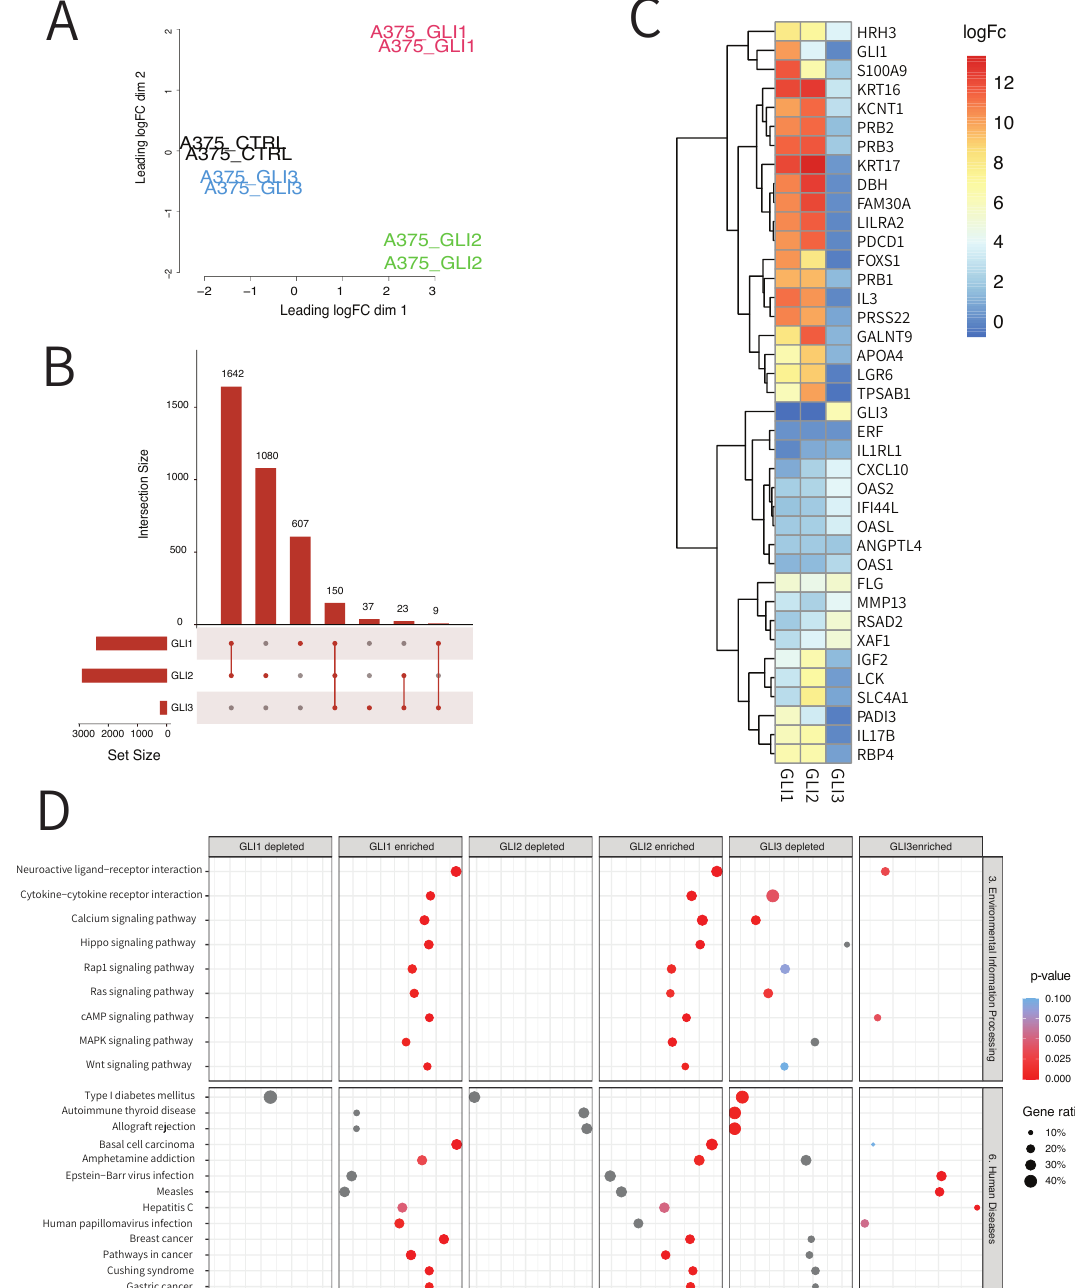
Figure 2. Expression profiles of CHL-1, A375, and MEL224 cell lines with transfected GLI1 , GLI2 and GLI3 . ( A ) MDS plot of A375 cell line. ( B ) Upset plot of differentially expressed genes across all cell lines and GLI proteins. ( C ) Heatmap of expression of top DEGs sorted by logFC across all cell lines. ( D ) Gene enrichment analysis of DEGs across cell lines, transfection with GLI1-3 vs. control. Upper half of the plot shows KEGG pathway analysis, while the lower part shows categories of diseases. On x -axis: normalized enrichment scores. Size of the circles denote ratio of DE genes in pathways. Color denotes significance, with gray and blue circles denoting non-significant enrichments and red denotes significant